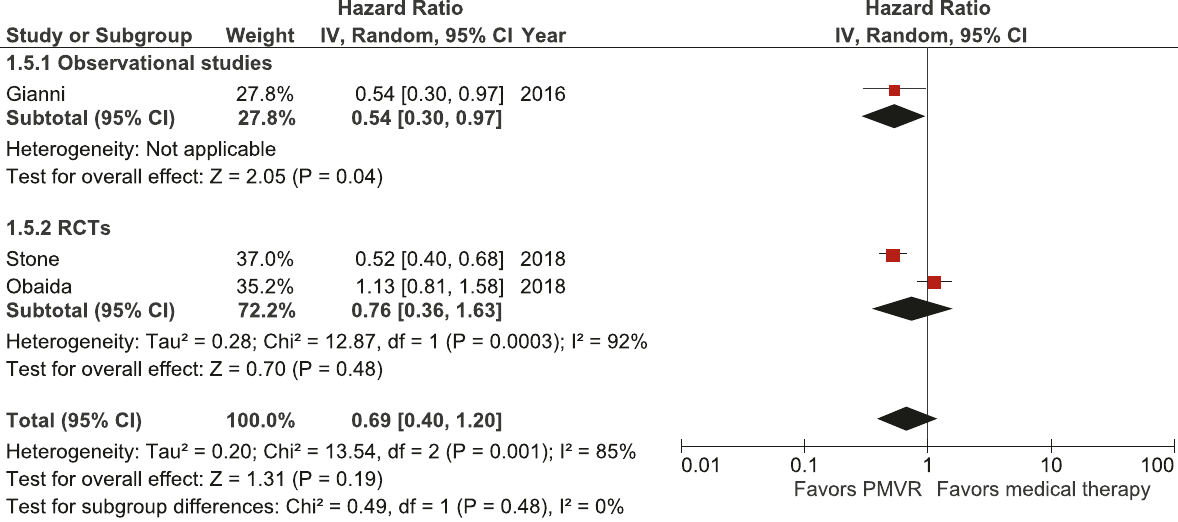
alone. However, HF hospitalizations and 30-day mortality were not significantly different between the two